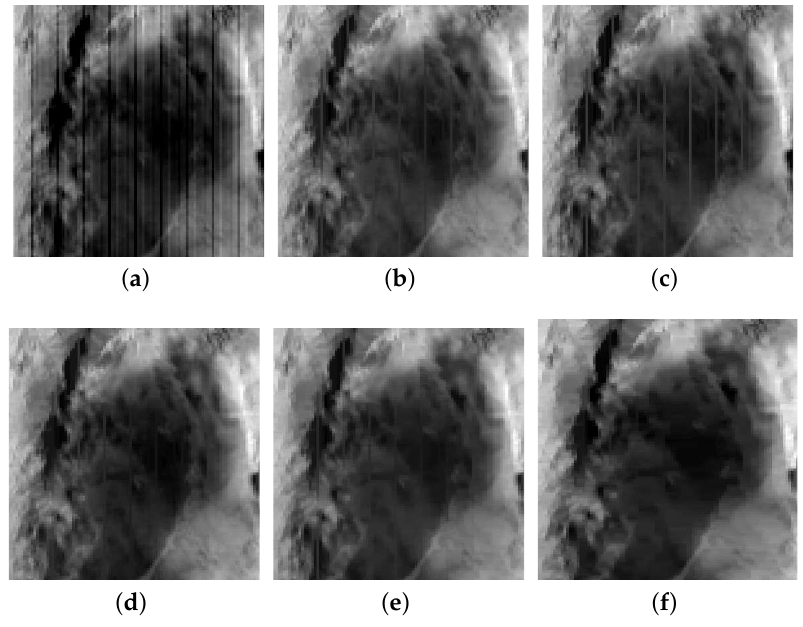
Figure 14. Zoomed results of Figure 13. ( a ) Original image; ( b ) WAFT; ( c ) SLD; ( d ) GSLV; ( e ) LRSID; ( f ) the proposed